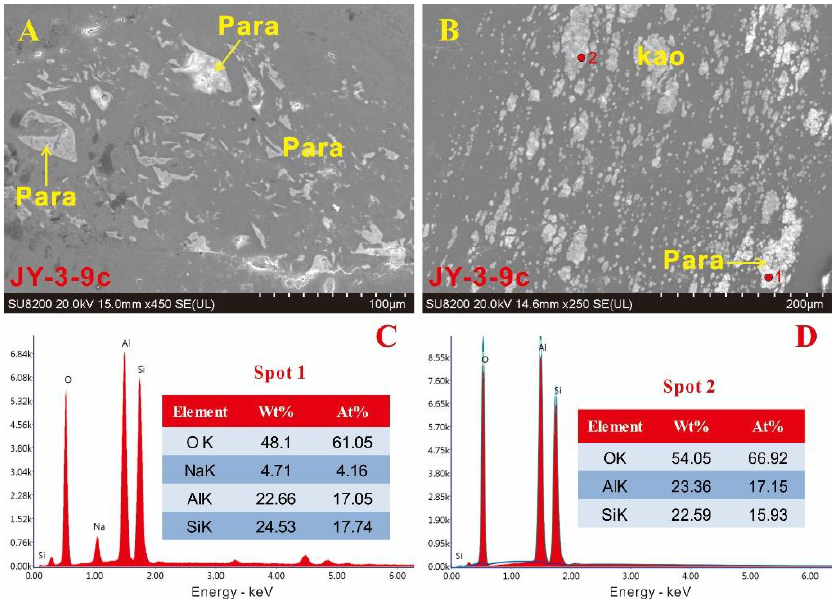
Figure 5. SEM secondary electronic images of paragonite (Para) and kaolinite (Kao) in sample JY-3-9c. ( A ), cell-filling paragonite; ( B ), paragonite co-existing with kaolinite; ( C , D ) are EDS spectrums of respective test spots in ( B ).